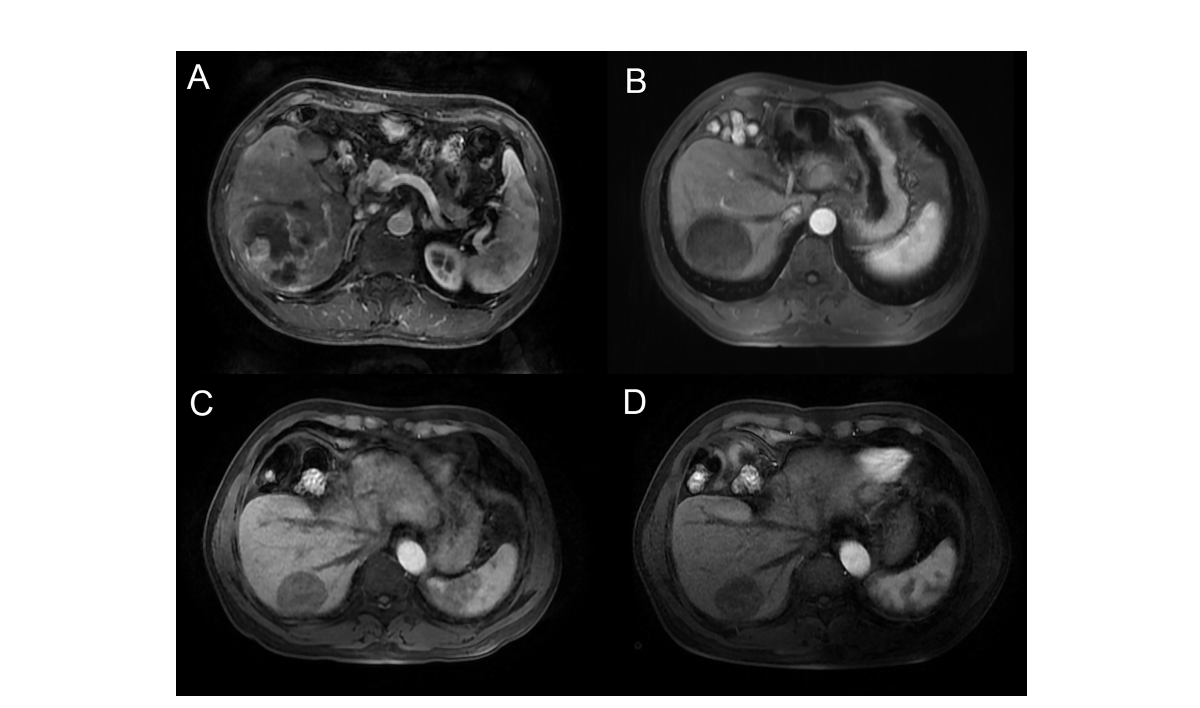
FIGURE 3 Male, 58y, BCLC B stage, Child-Pugh grade A6, massive and ruptured HCC. MR images (arterial phase) were acquired. (A) before TACE treatment, (B) 6 months after the combination treatment, (C) 12 months after the combination treatment, (D) 18 months after the combination treatment, demonstrating complete response, with a reduction in tumor size, the patient was classi fi ed as CR according to mRECIST. TACE, transarterial chemoembolization.